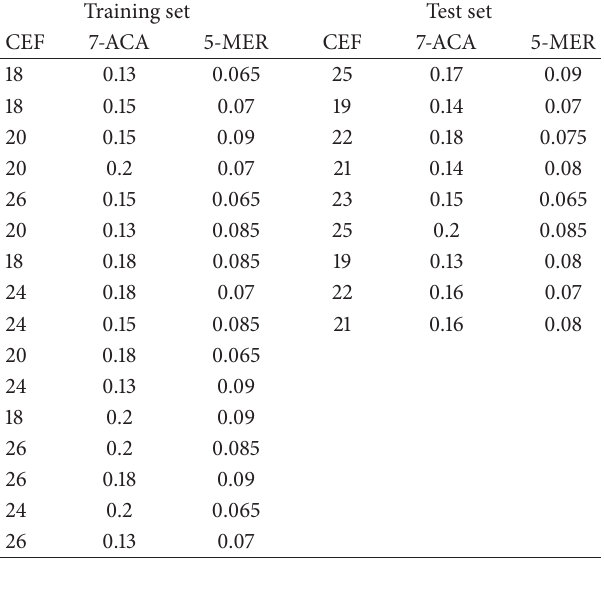
Table 1: Four-level three-factor experimental design of the training set (16 mixtures) and test set (9 mixtures) shown as concentrations of the mixture components in 𝜇 gmL −1 .